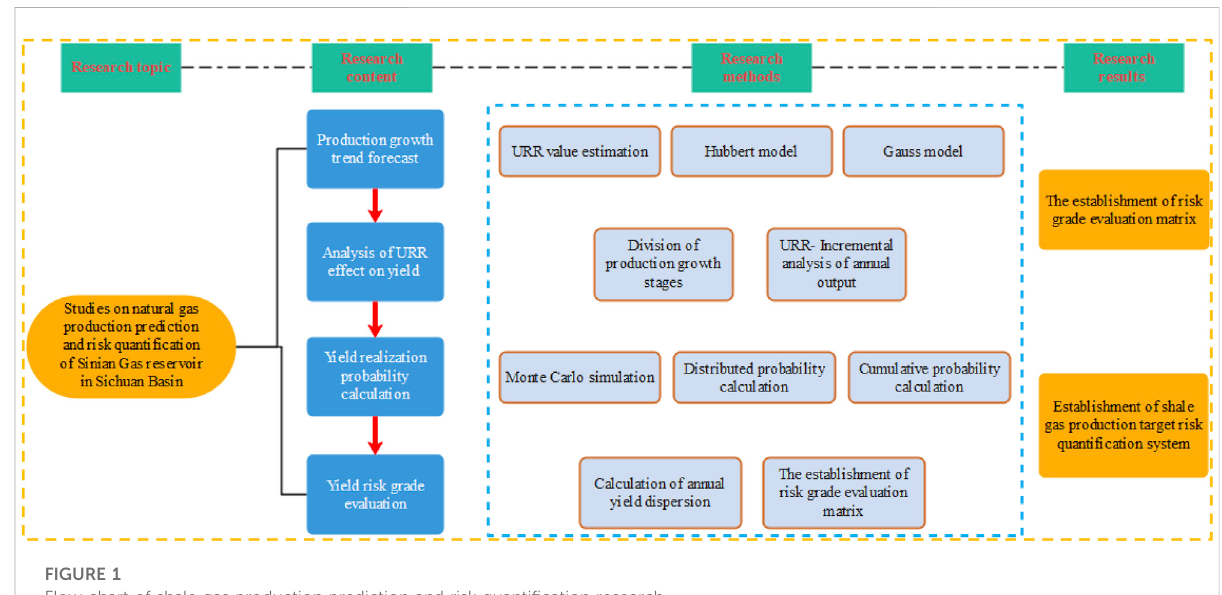
FIGURE 1 Flow chart of shale gas production prediction and risk quanti fi cation